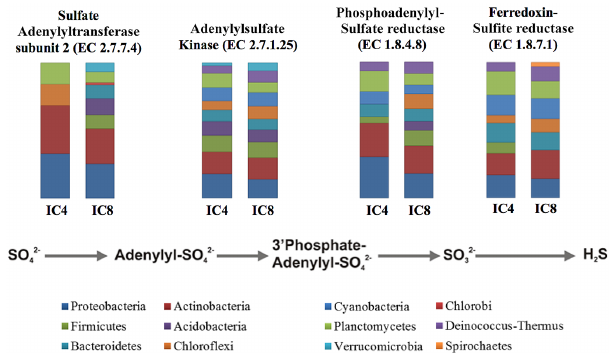
Figure 6. Phylogenetic distribution of the sequences related to sulfur metabolism (sulfur reduction) within the IC4 and IC8